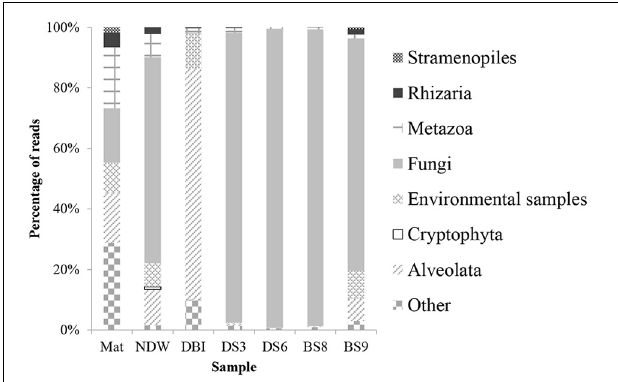
FIGURE 1 | Taxonomic classification of eukaryotic 18S amplicon reads using the QIIME pipeline. The qualified 18S rRNA amplicon reads were classified into kingdoms using the RDP classifier against Silva108 with a confidence level of 50%. The sample IDs were defined in Table 1 .